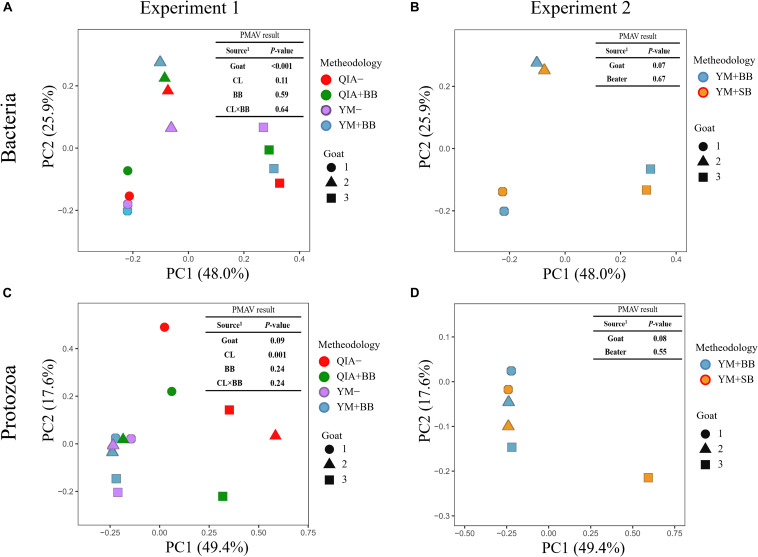
Principal coordinate analysis (PCoA) plots for the community of bacteria (A,B) and protozoa (C,D) based on the Bray–Curtis dissimilarity matrix. QIA, the chemical lysis provided by QIAamp Fast DNA Stool Mini Kit methodology; YM, the chemical lysis provided by RBB + C (Yu and Morrison, 2004); BB, bead beating; SB, sand beating; QIA–, QIA without mechanical lysis; QIA + BB, QIA with BB; YM–, YM without ML; YM + BB, QIA with BB; YM + SB, QIA with SB; PMAV, permutational multivariate analysis of variance with 999 permutations. Experiment 1 is a 2 × 2 factorial analysis and includes four methodologies, such as QIA–, QIA + BB, YM–, and YM + BB (A,C). Experiment 2 compares YM + BB and YM + SB (B,D).